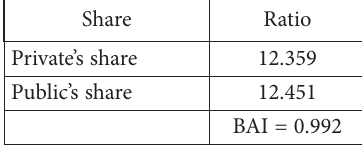
Table 12. BAI measurement in risk allocation frameworks